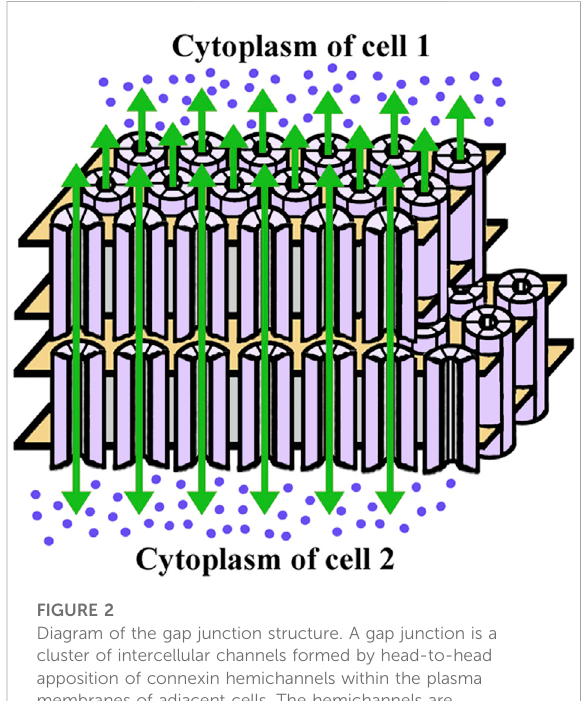
FIGURE 2 Diagram of the gap junction structure. A gap junction is a cluster of intercellular channels formed by head-to-head apposition of connexin hemichannels within the plasma membranes of adjacent cells. The hemichannels are hexameric assemblies of connexin proteins surrounding a central aqueous pore and are depicted as cylinders formed of six subunits (light violet). The boundaries of the plasma membrane are illustrated in gold. The green arrows indicate the intercellular passage of ions and small molecules (ultramarine blue dots) through the gap junction channels. While the channels allow bidirectional fl ow, there is a net outwards fl ux of water and ions in the